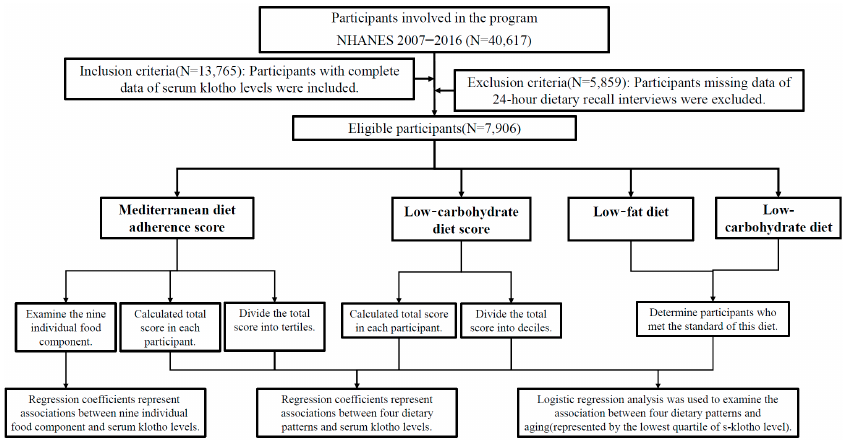
Figure 1. Flow chart of study population selection.